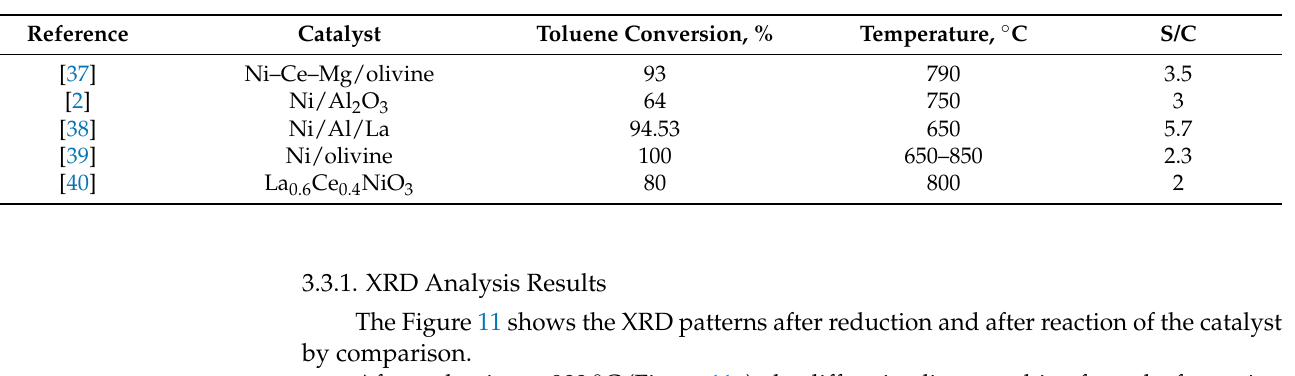
Table 7. Comparison of the catalytic performances of previously reported